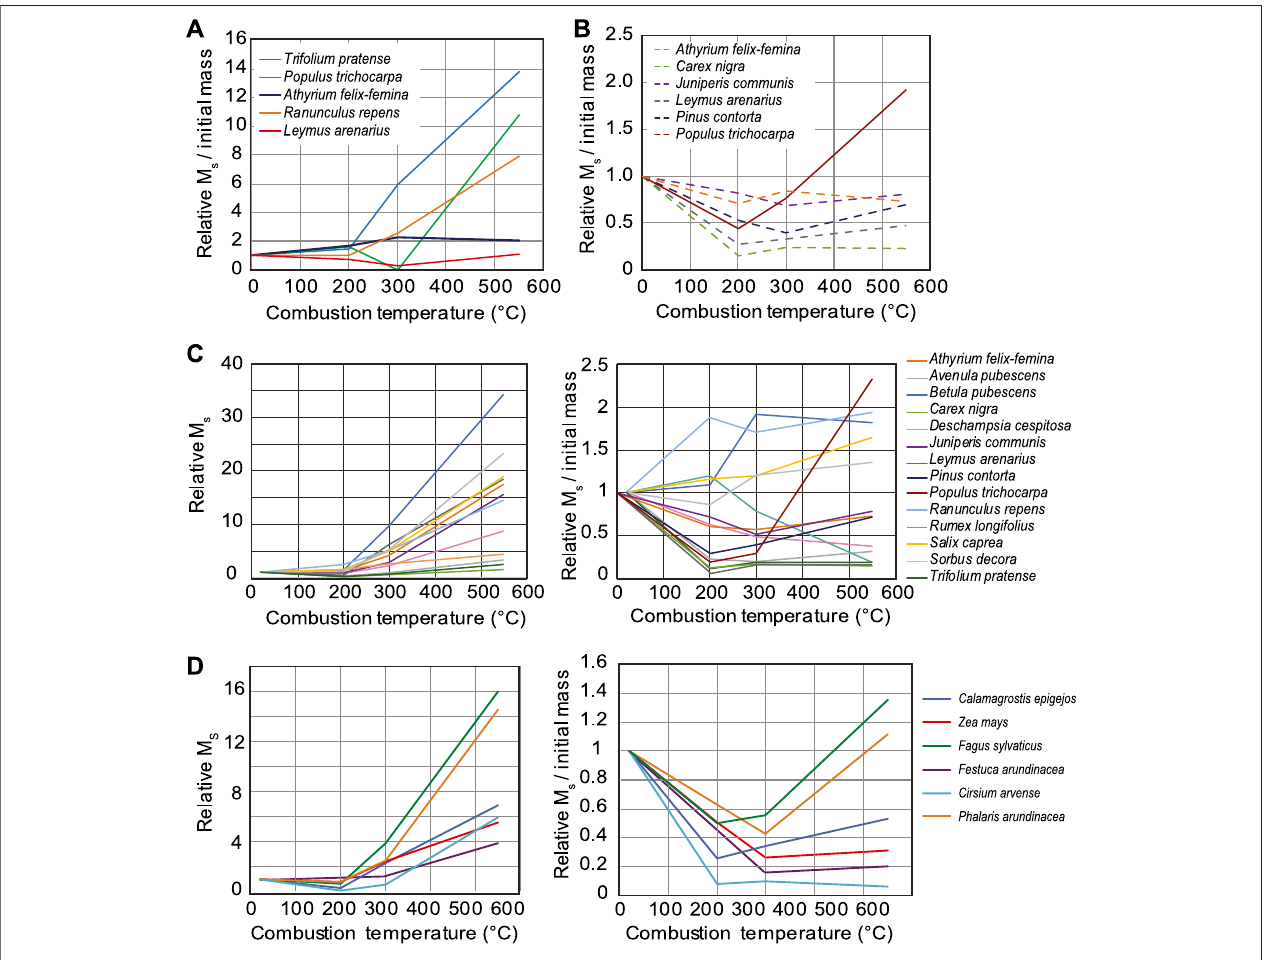
FIGURE 7 | Changes in saturation magnetization values in ash and char with burning relative to unburnt material for (A) green leaves from Icelandic plants, (B) uncleanedIcelandicplantlitter, (C) cleanedIcelandicplantlitter,and (D) Germanplantsamples.LefthandplotsinCandDshow M s normalizedbyash/charsamplemass after burning while the righthand plots, as well as those in A and B, indicate relative M s normalized by the initial plant mass prior to burning.